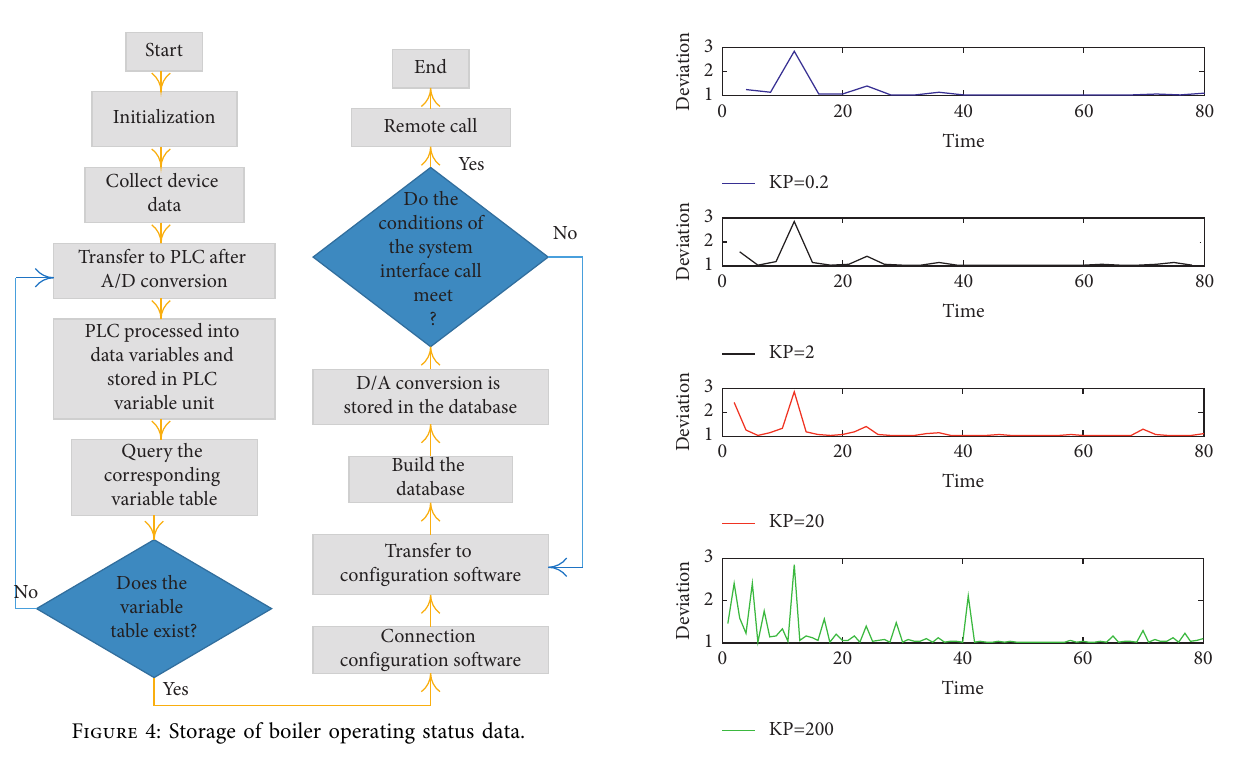
Figure 5: The influence of KP on the transition process (KI � KD � 0).